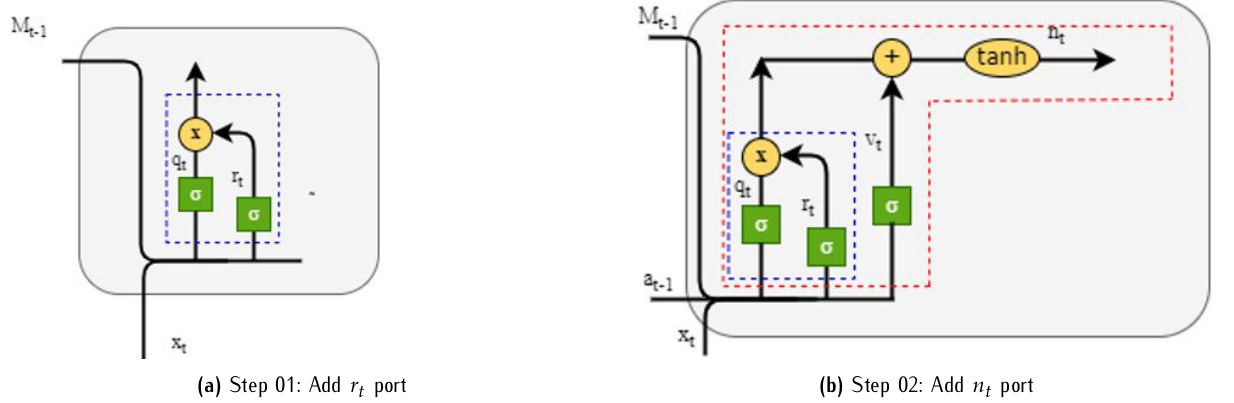
Figure 5. Operation of the Reset